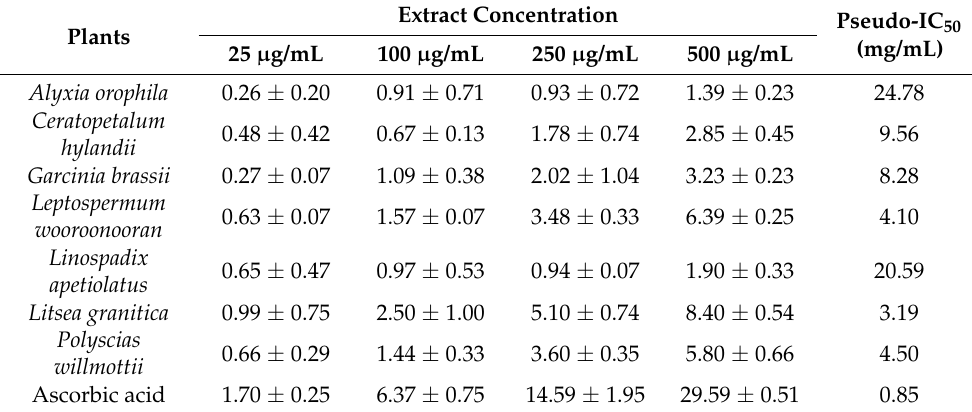
Table 3. Ferric reducing antioxidant power (FRAP) values of selected seven Wet Tropics